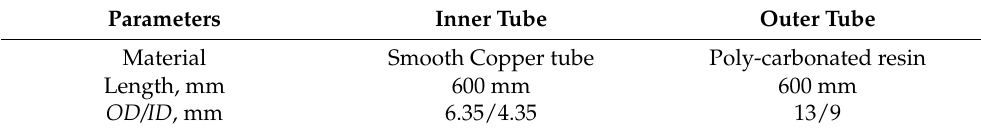
Figure 8. Photograph of the condenser. Table 6. Specification of the condenser.